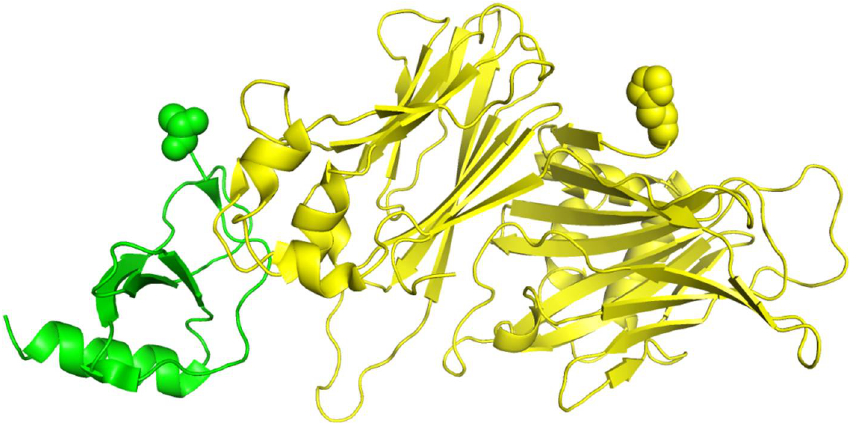
Figure 4. The 3D structure illustration for protein complex 1ML0. Its A and D chains are colored in yellow and green, respectively. A yellow or green ball indicates where some residue(s) should be present but missing.